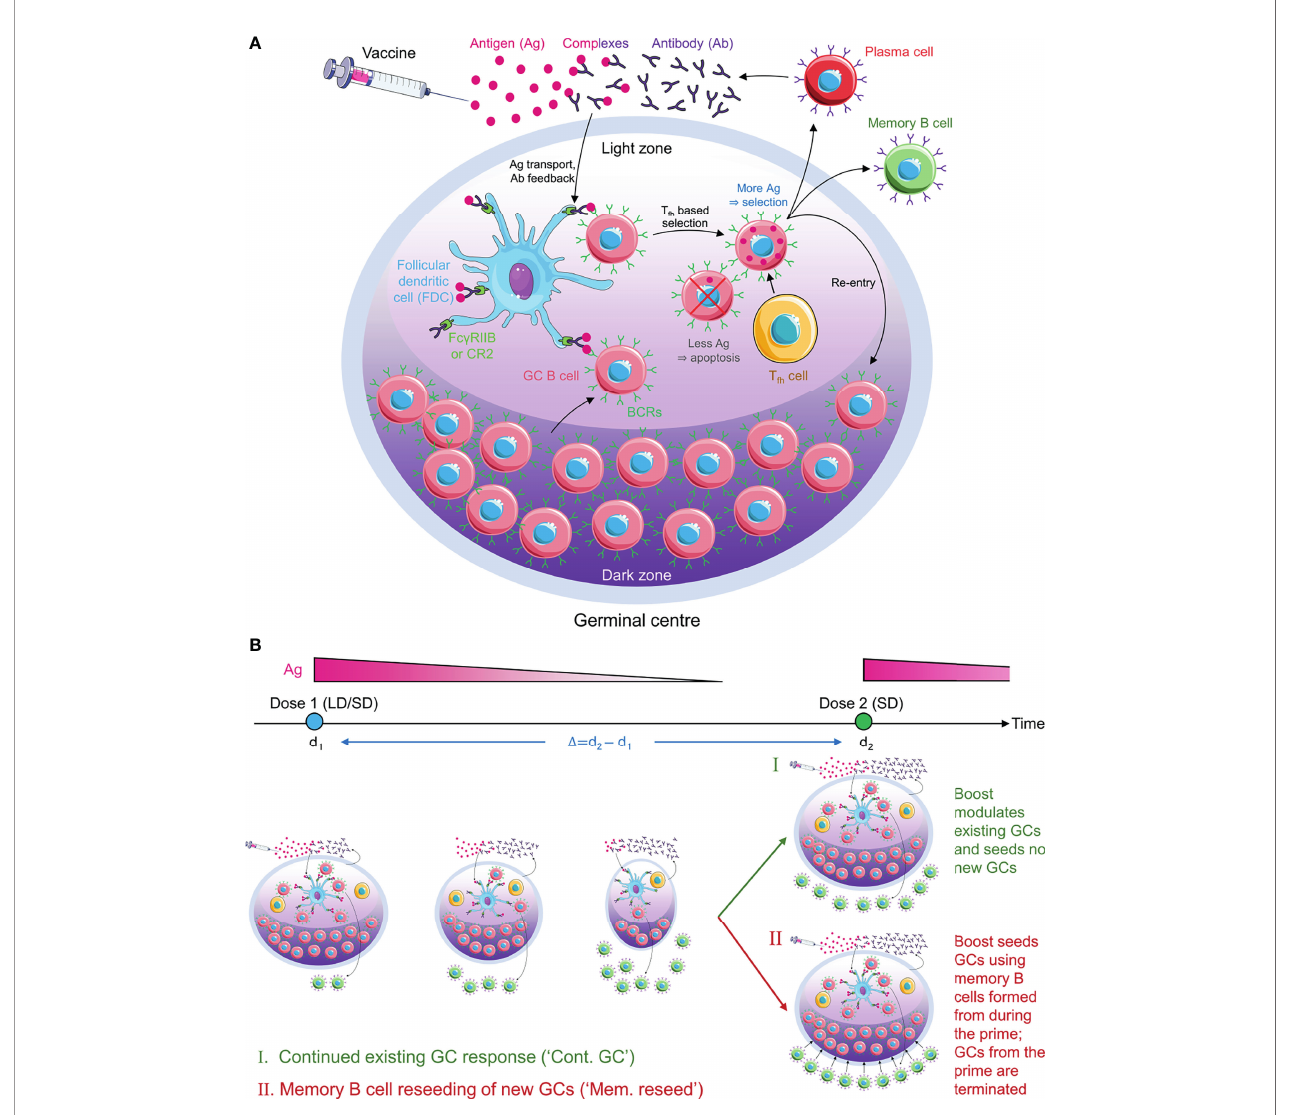
FIGURE 1 | Schematic of the GC reaction model post vaccination. (A) The GC reaction. The antigen from the vaccine enters the GC complexed to antibodies and is presented in the light zone on the surfaces of follicular dendritic cells attached to Fc g RIIB or CR2 receptors. GC B cells acquire antigen with a probability proportional to their af fi nity for the antigen. They then receive help from T follicular helper cells with a probability dependent on the relative amount of antigen they acquired. Cells that fail to acquire antigen or receive the latter help die. Cells that succeed can exit the GC to become plasma cells and secrete antibodies, become memory B cells, or migrate to the dark zone, where they proliferate and mutate their antibody genes. The latter cells circulate back to the light zone and become subjected to the same selection process. Antibodies secreted by plasma cells can feedback into the GC and affect the selection process. (B) Schematic of the simulations. (Top) Timeline showing dose administration and corresponding antigen levels. (Bottom) GCs are formed following the prime and gradually shrink with time due to decreasing antigen levels. The prime could be low dose (LD) or standard dose (SD). The boost could restore existing GCs (mechanism I) or lead to new GCs seeded by memory B cells formed during the prime (mechanism II). The boost is typically